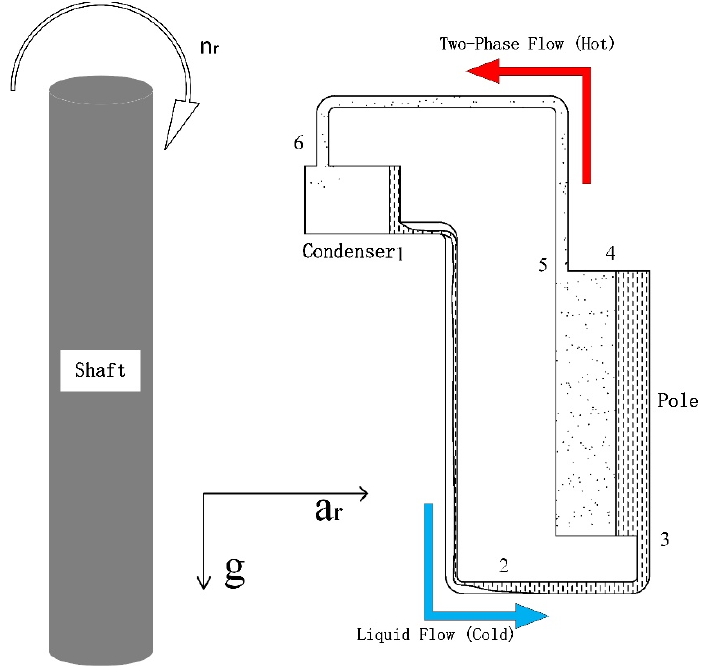
Figure 2. The schematic of rotor evaporative cooling system.